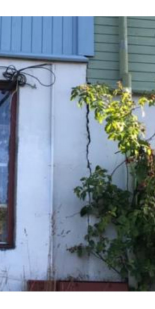
Figure 10. Crack between the buildings Strandveien 19 and 21 (NTNU).